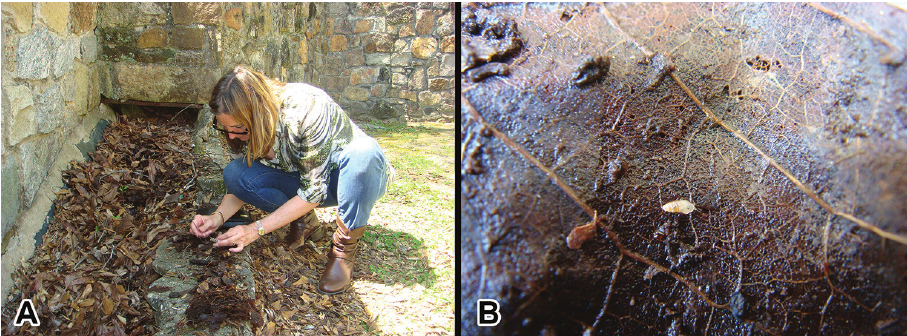
Figure 10. Type locality of Carychium hardiei sp. n., Indian Springs State Park, Flovilla, Georgia, USA. A collector A. Jochum; B Carychium hardiei in action on rotten